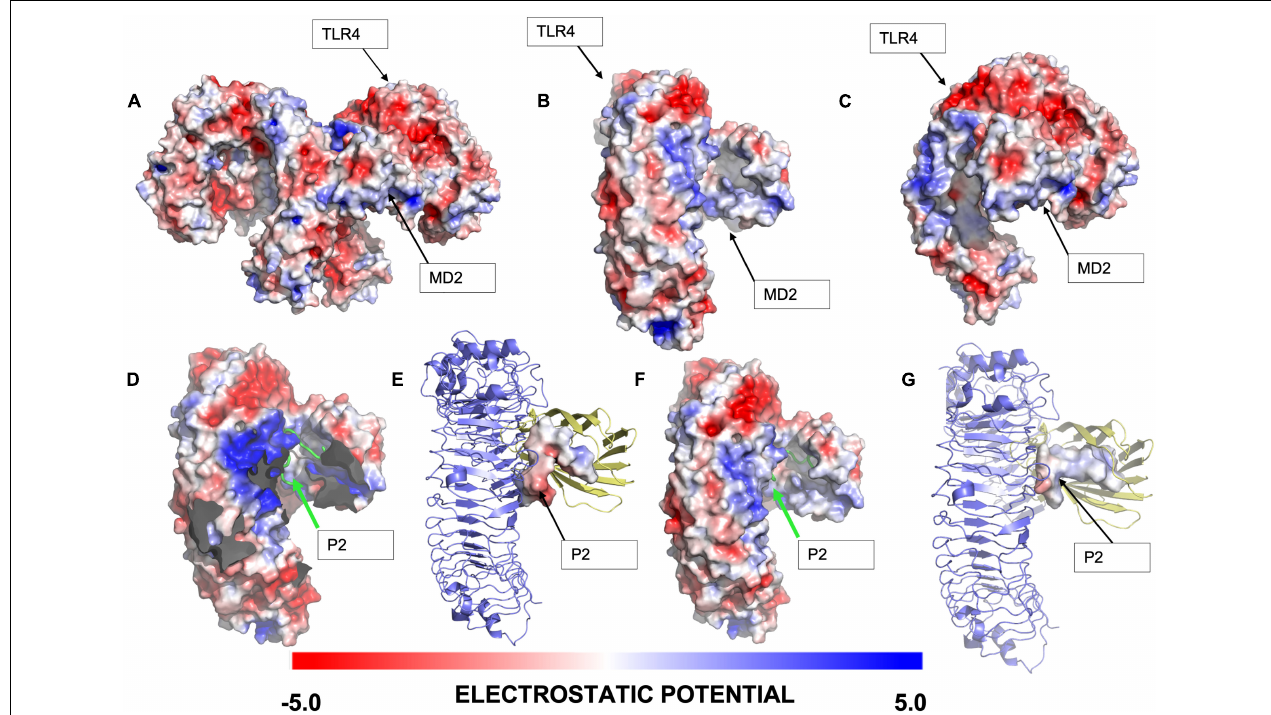
FIGURE 1 | Electrostatic analysis of the interaction of the highest ranked docking conformation of Peptide-2 with murine TLR4/MD2 complex (PDB ID = 3VQ2) obtained with Autodock Vina 1.1.2 and generated with PyMOL 2.4.1. (A) General view of (mTLR4/MD2) 2 electrostatic potential. (B) Frontal view of (mTLR4/MD2) electrostatic potential. (C) Lateral view of (mTLR4/MD2) electrostatic potential. (D) Best docked conformation for Peptide-2 with (mTLR4/MD2) 2 , with complementary TLR4/MD2 not shown for visualization purposes. (E) Electrostatic potential of best docked peptide conformation of Peptide-2 with (mTLR4/MD2) 2 . (F) Best docked peptide conformation for Peptide-2 with (mTLR4/MD2). (G) Electrostatic potential of best docked conformation of Peptide-2 with (mTLR4/MD2). The electrostatic potential is shown in a red (–5) to blue (+ 5) scale obtained with the APBS electrostatics plugin in PyMOL